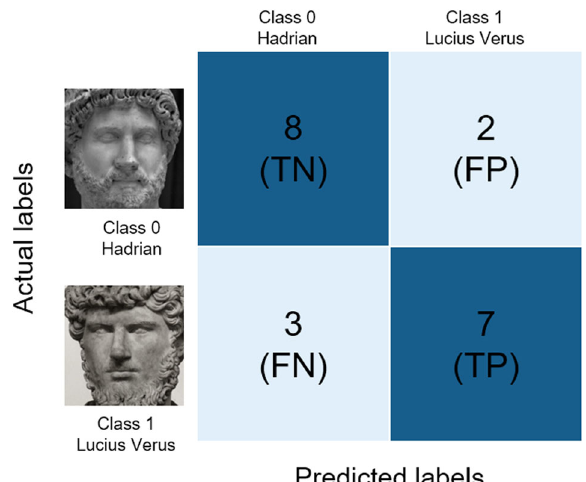
Fig. 7 Confusion matrix for a simple binary classi fi er. As an example a simple binary classi fi er ’ s performance is measured here where the model correctly classi fi es eight out of ten images of Hadrian but also identi fi es two images as Lucius Verus. Same analysis applies to the class Lucius Verus.